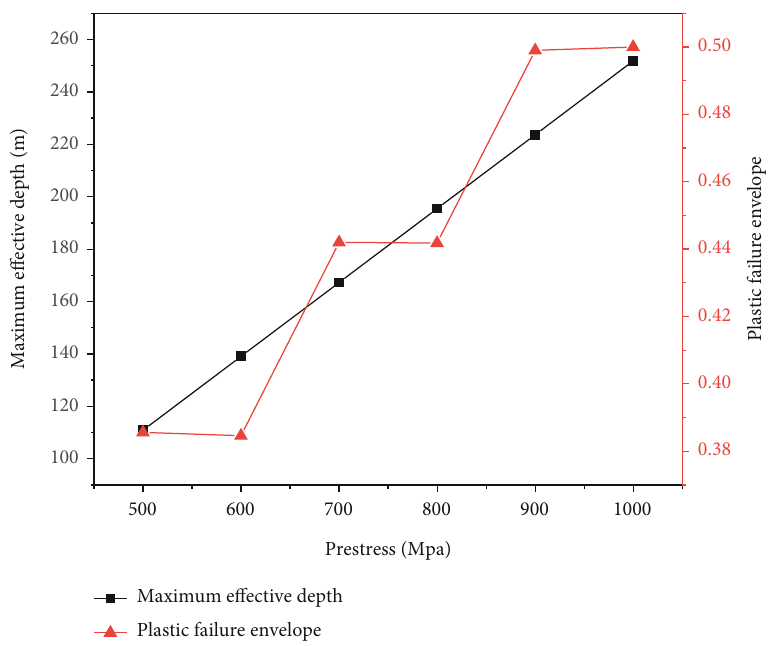
Figure 7: Failure envelopes of soil under di ff erent prestress p